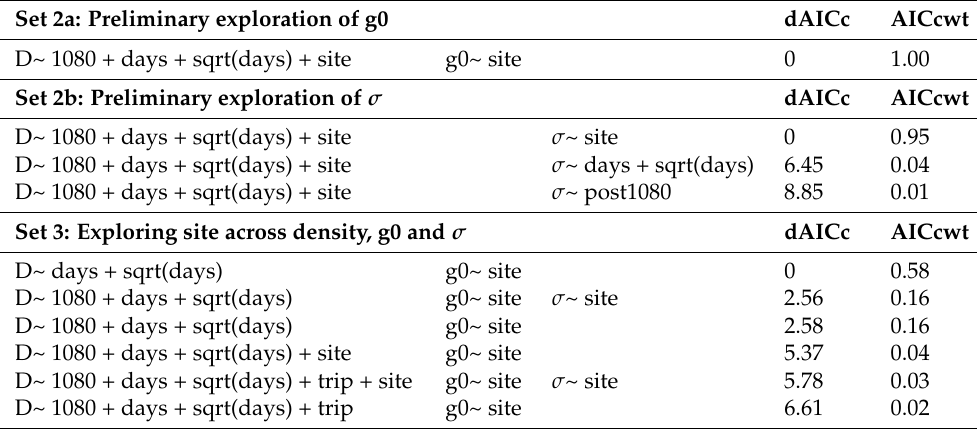
Table 2. Summary of model sets 2 and 3 (all models with dAICc <